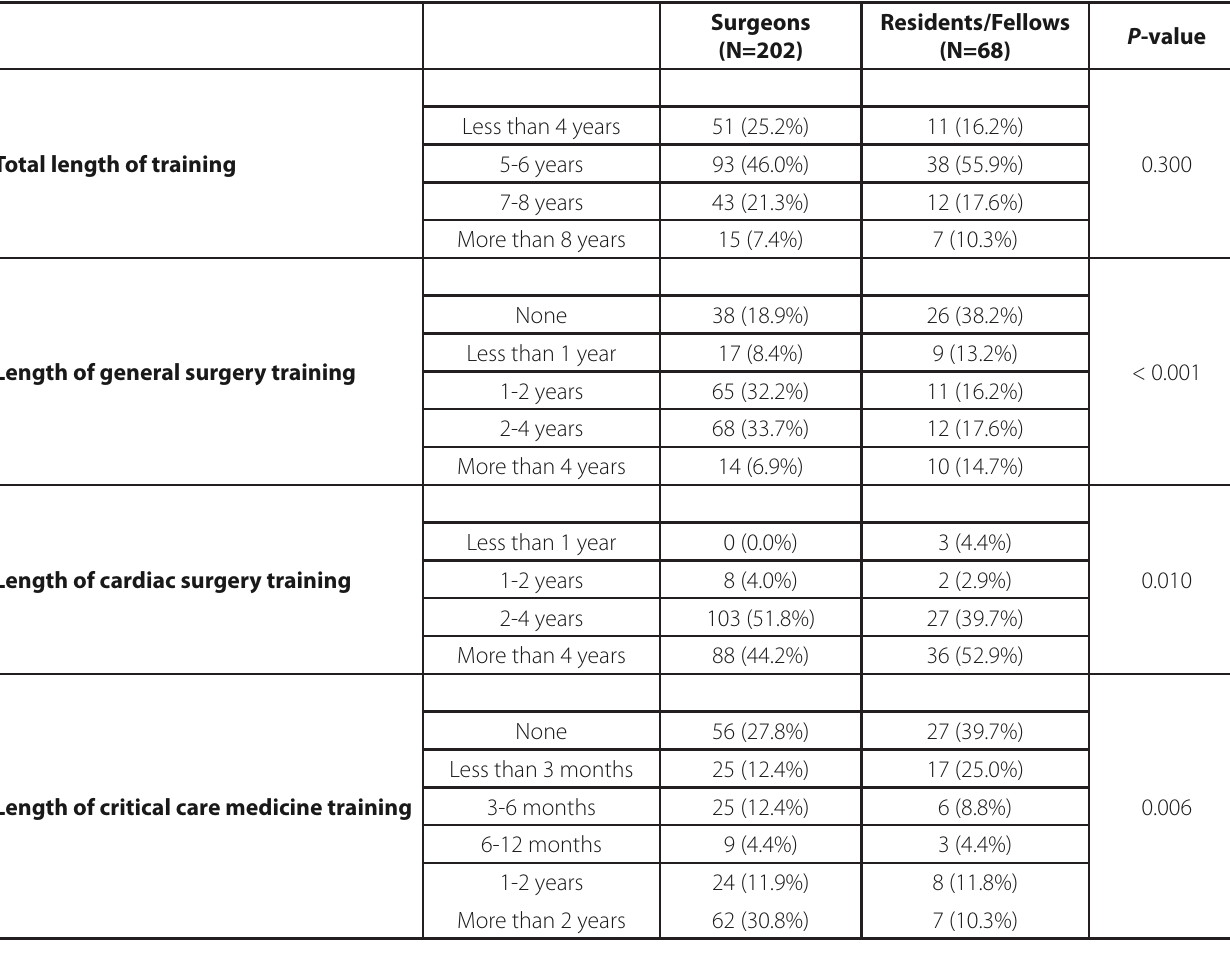
Table 2. Training durations reported by cardiac surgeons, residents, and fellows.